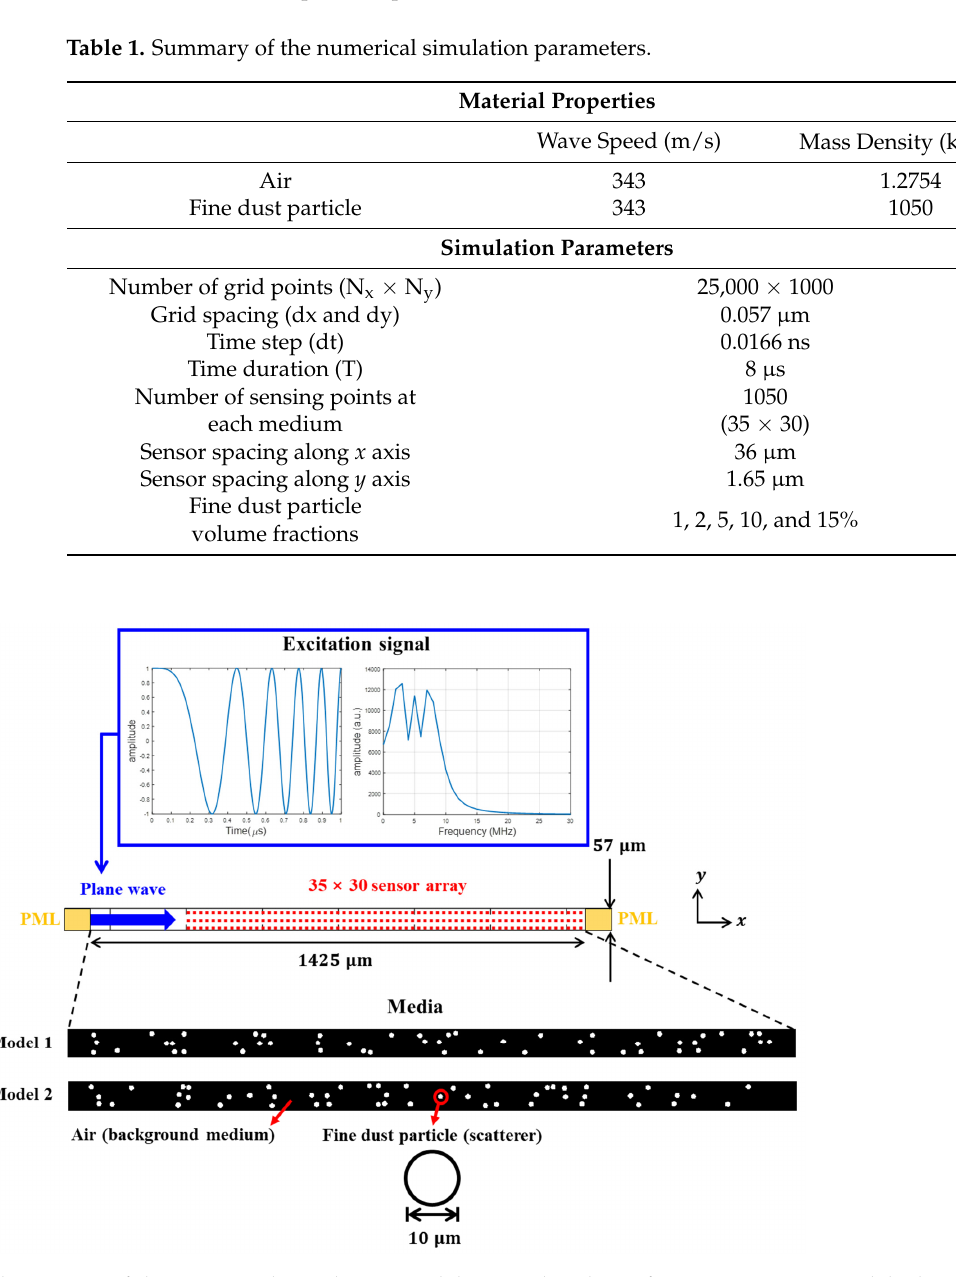
Figure 3. The overall structure of the numerical simulation model. At each volume fraction case, two models that had different scatterer distributions were simulated to obtain acoustic wave responses across multiple realizations. Table 1. Summary of the numerical simulation parameters.